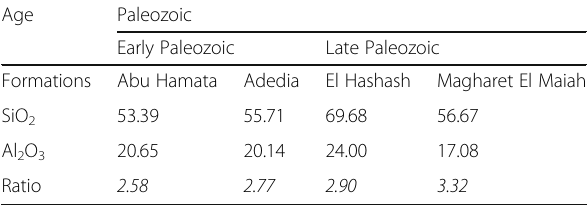
Table 5 Ca/Mg ratio of the studied Paleozoic